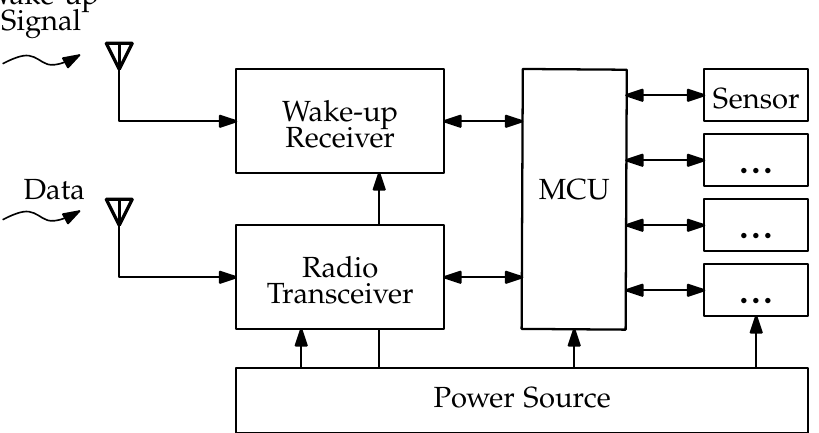
Figure 1. Block diagram of sensor node’s functional